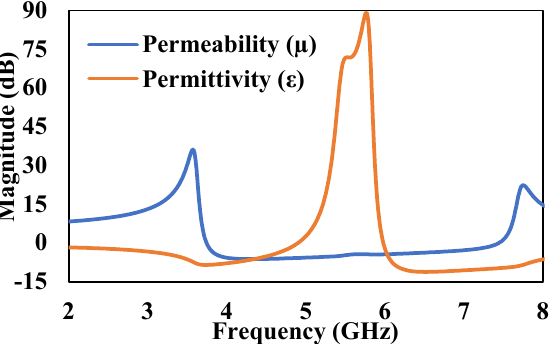
Figure 8. Simulated Permeability and Permittivity response of metallic-cross unit-cell.